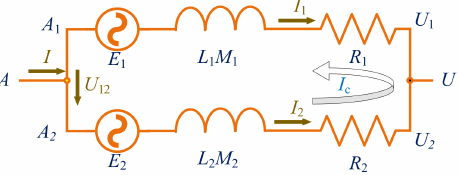
Figure 4. Circulating current loop between parallel branches of stator winding. Where R1, R2, L1, and L2 are the resistance and self-inductance of two parallel branches of the A-phase, respectively. M1 and M2 are the mutual inductances of each branch and other branches, respectively. I1 and I2 are the currents corresponding to the two branches, Ic is the circulating